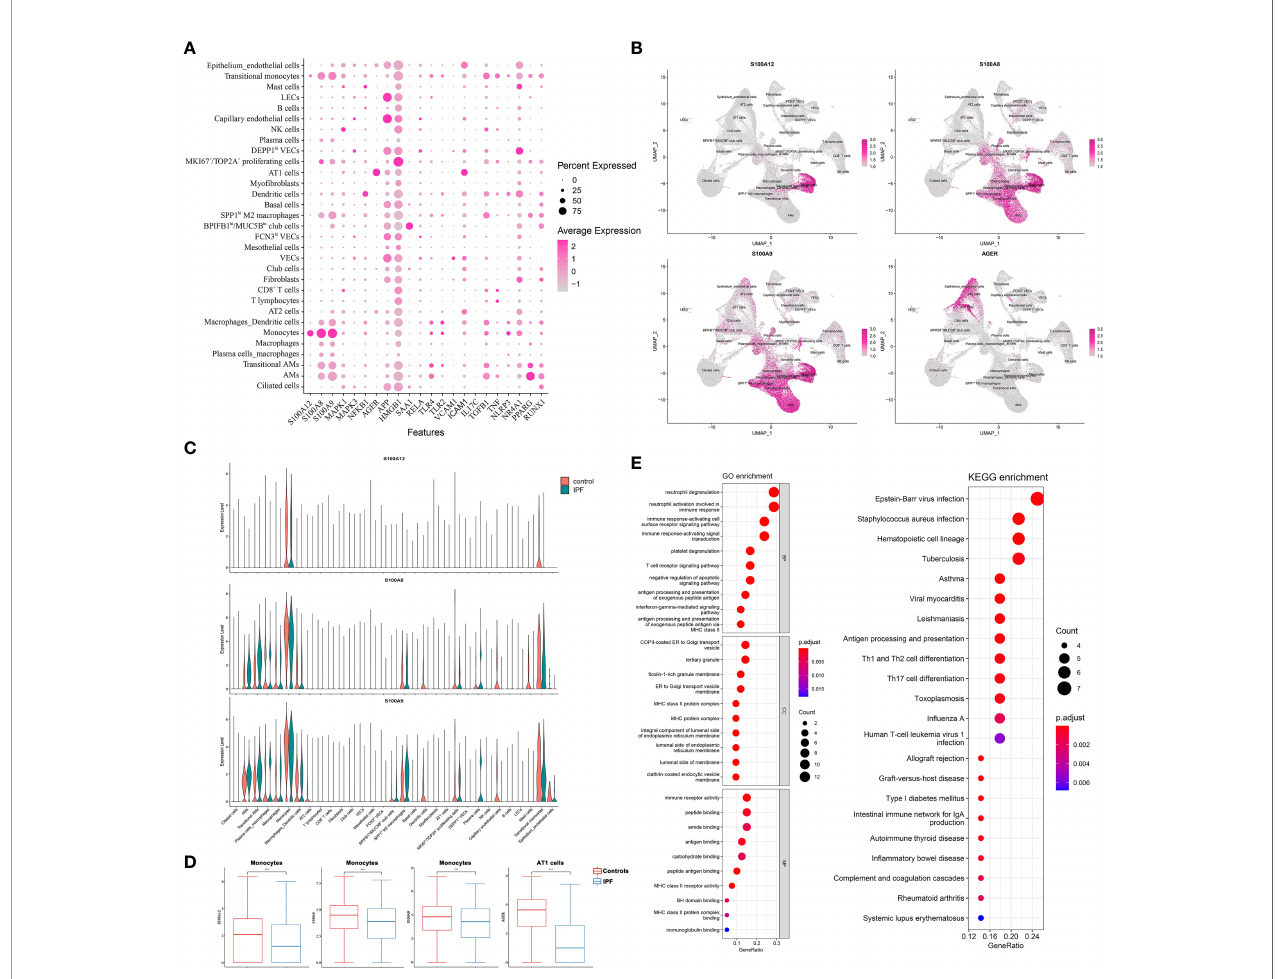
FIGURE 8 | The scRNA-seq analysis in the GSE135893 dataset (IPF = 12, control = 10). (A) Color dot plot of S100A12 and its partners; (B) Feature plot of S100A12, S100A8, S100A9, and AGER; (C) Violin plot of S100A12, S100A8, and S100A9. (D) The different expressive analysis of S100A12, S100A8, S100A9, and AGER between IPF and controls in the selected cell type; (E) The GO and KEGG analysis of DEGs between IPF and controls in the monocytes with S100A12